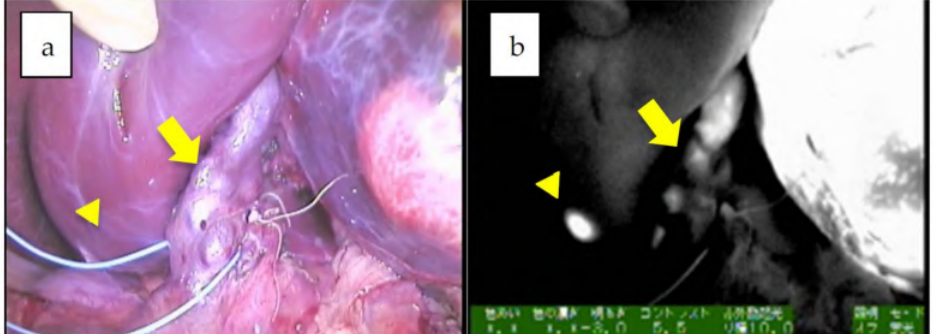
Figure 1. a , b : Multiple fluorescent spots are observed under near-infrared (NIR) in the liver. Of note, some nodules show a rim-type fluorescence pattern, indicated by an arrowhead (combined fetal and embryonal subtype, post-chemotherapy).